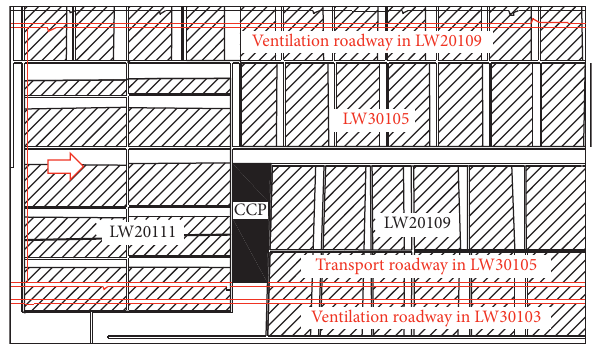
Figure 1: Layout of concentrated coal pillar in No.30105 working face.